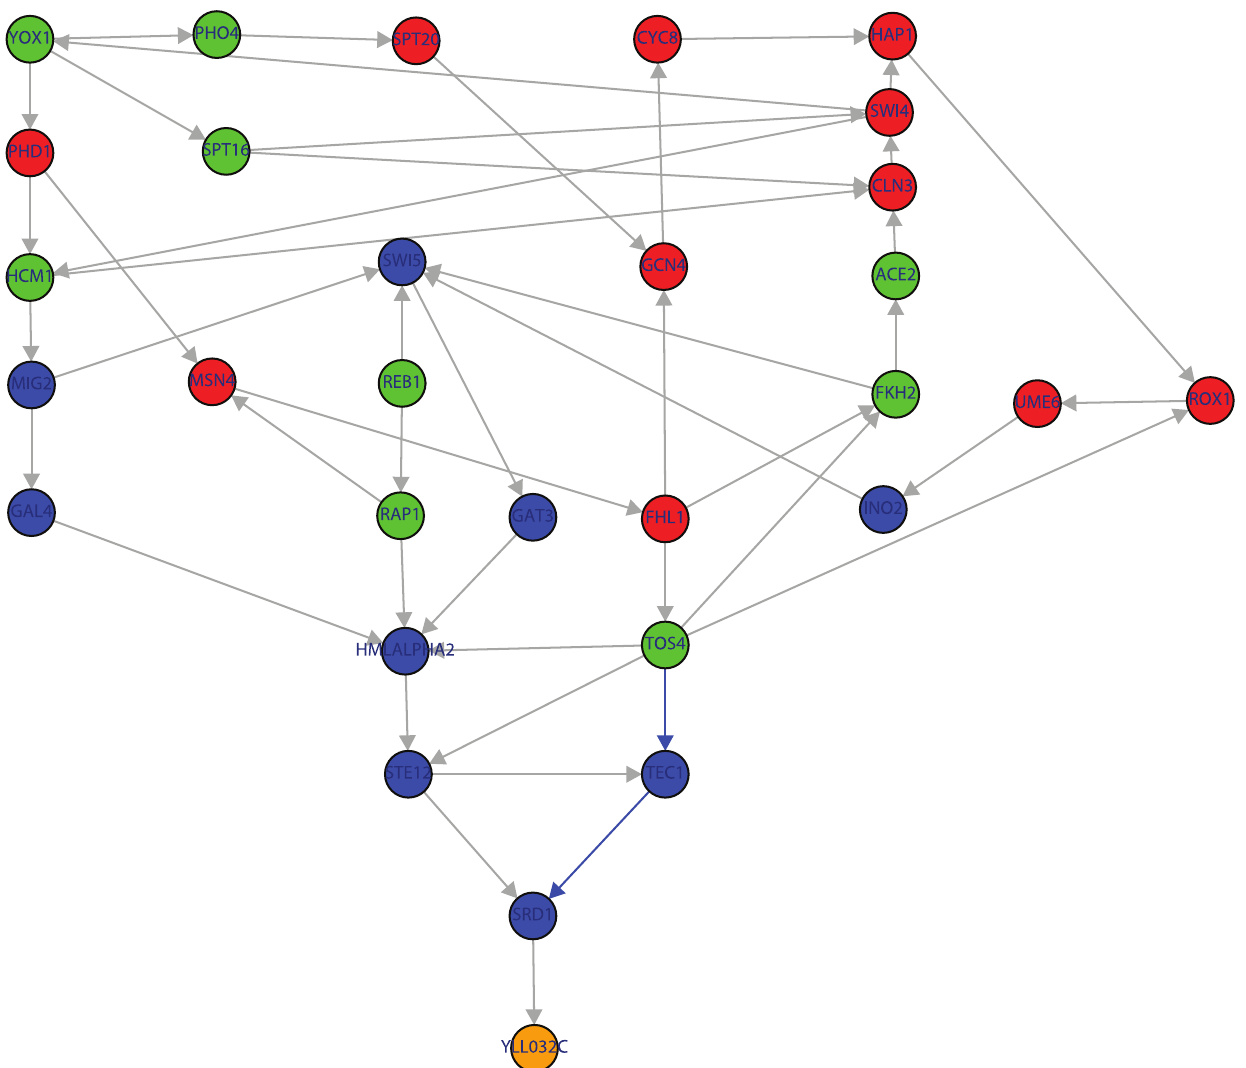
Figure 7. Subnetwork of the TRN of yeast containing 30 genes. Color code of the nodes is as in Fig. 1. The shown subnetwork complements the results in table 1 by providing detailed information about the genes involved in the shortest paths. Blue edges indicate the shortest path connecting TOS4 R TEC1 R SRD1 R YLL032C.